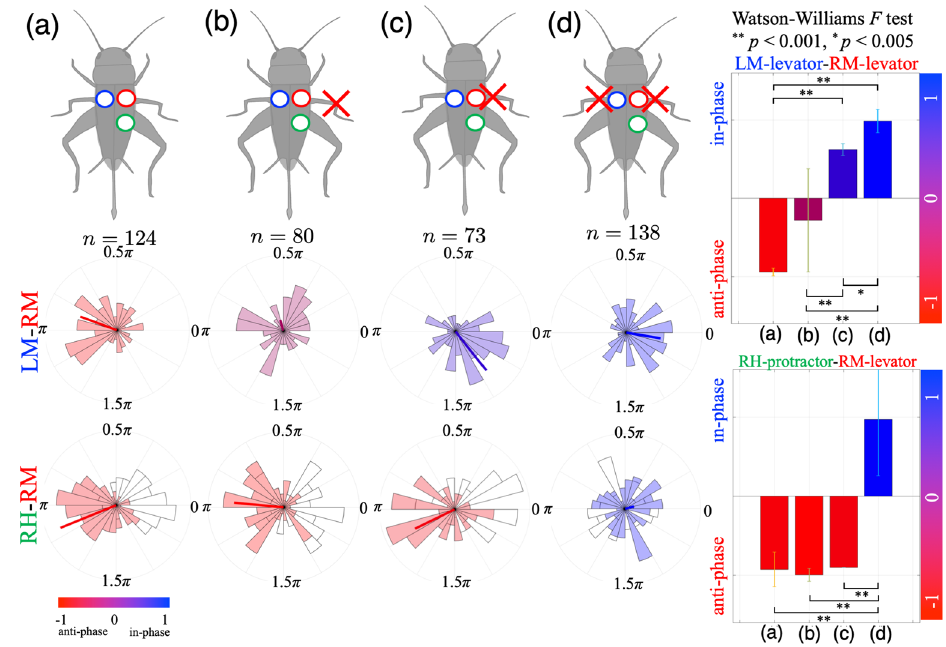
Figure 3. Change in muscle activation timing before and after leg amputations. The phase relationships of leg muscle activations between the LM and RM levators (left middle panels) and between the RM levator and RH protractor (left bottom panels) in conditions ( a – d ) using circular histogram plots. Experimental conditions: ( a ) Intact walking; ( b ) Right middle leg amputated at the FTi joint; ( c ) Right middle leg amputated at the CTr joint; ( d ) Both middle legs amputated at the CTr joint. We changed the experimental conditions in the order from ( a ) to ( d ) by amputating cricket legs at 3 different positions as shown in the upper left panels. Walking during more than 5 periods was analysed as one trial for each condition. To calculate the phase relationship of muscle activations in the corresponding trial, we conducted cross-spectrum analysis 41 . The bold line in the left panels shows average phase; the line length represents the standard deviation (0 to 1, with a larger deviation approaching 0 and a smaller deviation approaching 1) of the phase relationships of muscle activations over all trials. The colours (histogram and bar) are indices representative of degrees of in-phase/anti-phase synchronisation I sync (see “Methods” section). The right panels show changes in the average phase and standard deviations on the RM-LM and RM-RH muscles over the four conditions. The phase relationship between the LM and RM leg muscles gradually changes from anti-phase synchronisation in ( a ) to in-phase synchronisation in ( d ). For the RH and RM muscles, the phase relationship shifts to in-phase synchronisation in condition ( d ). The Waston-William F test was used to reveal differences in phase relationships between the conditions. A p -value of 0.005 was set as the criterion for statistical